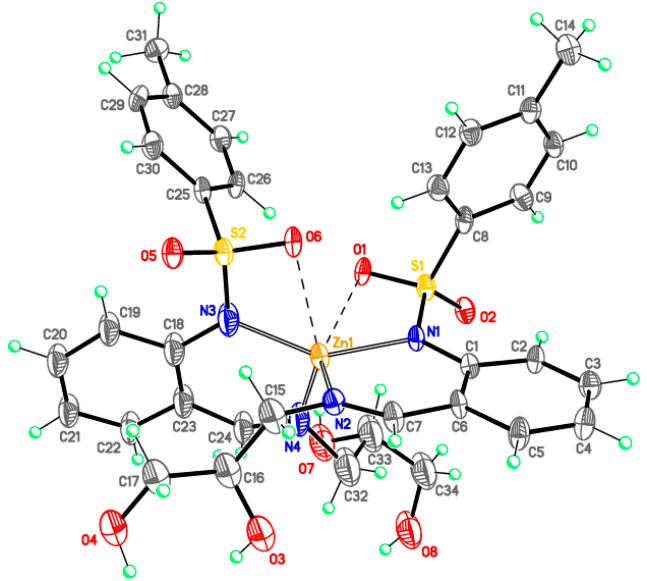
Figure 3. Molecular structure of 2-Zn . The alternative orientation of the disordered 2,3-dihydroxypropyl substituent as well as the solvate dimethylformamide molecule are not shown for clarity. Displacement ellipsoids are shown at the 50% probability level. Dashed lines indicate secondary Zn…O interactions. Selected bond lengths and angles (Å and ): Zn1–N1 2.035(5), Zn1–N2